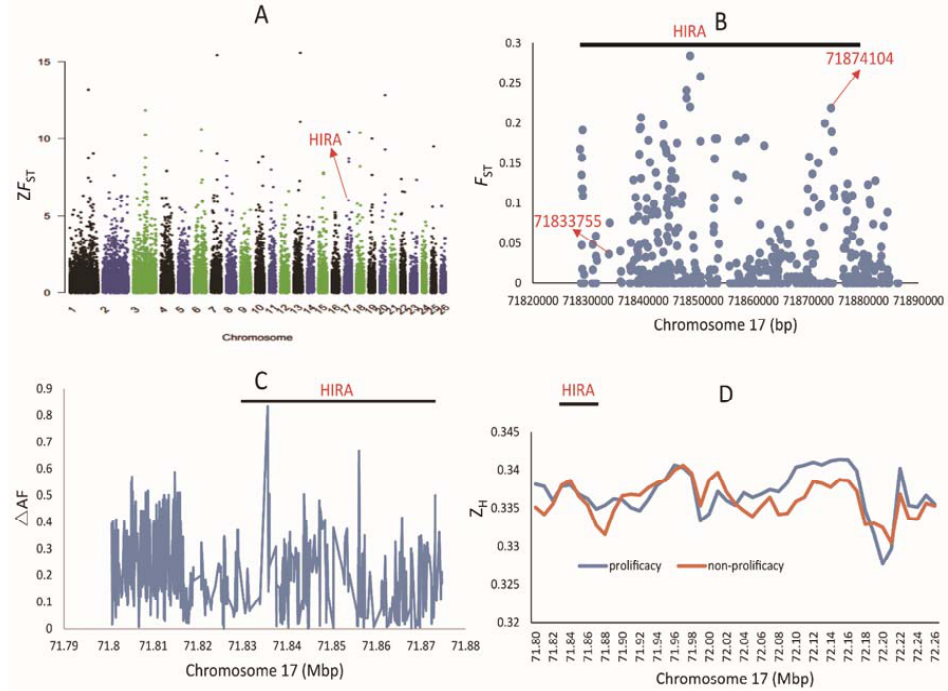
Figure 1. Manhattan plots of genome ‐ wide Z F ST and signals of selective sweeps in the region 71.80–71.87 Mb. ( A ). Manhattan plots of genome ‐ wide Z F ST and the positive selected genes; ( B ). The Scatter plot of F ST value in selected region near 71.80–71.87 Mb; ( C ). Δ AF value between fecundity and non ‐ fecundity sheep in the region near 71.80–71.87 Mb; ( D ). Z H value between fecundity and non ‐ fecundity sheep in the region near 71.80–71.87